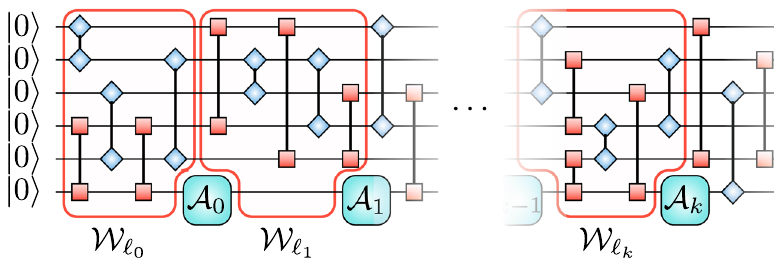
Fig. 4 Circuit diagram for a quantum process which can Markovianize under only two different types of 2-qubit interaction dynamics. For an n -qubit system (where each 0 j i is a single qubit), the unitaries W ‘ , composed of ℓ alternate repetitions only two distinct types of random interactions (depicted by diamonds and squares joined by the interacting qubits), and de fi ned by Eq. (42), generate an ϵ -approximate unitary t -design whenever ℓ ≥ t − log 2 ( ϵ )/ n , as shown bt Winter et al. 14 . This can be thought as stemming from repeated alternate applications of random 2-qubit gates diagonal in only two Pauli bases. A qubit probed with a set of operations f A i g on a system undergoing ϵ -approximate unitary t -design dynamics W ‘ on a large environment will Markovianize for small design error ϵ and large complexity t as speci fi ed in the main text.